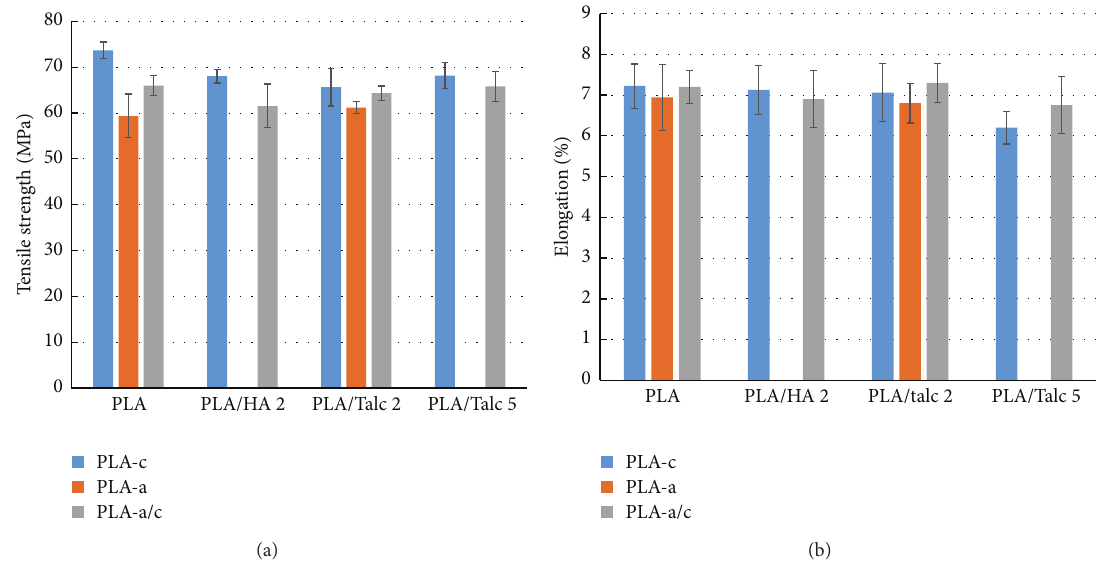
Figure 7: Effect of different inorganic fillers on the tensile strength and elongation of